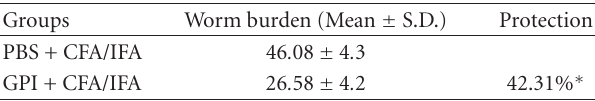
Table 1: Worm burden reduction and protection level induced in mice vaccinated with GPI-anchored